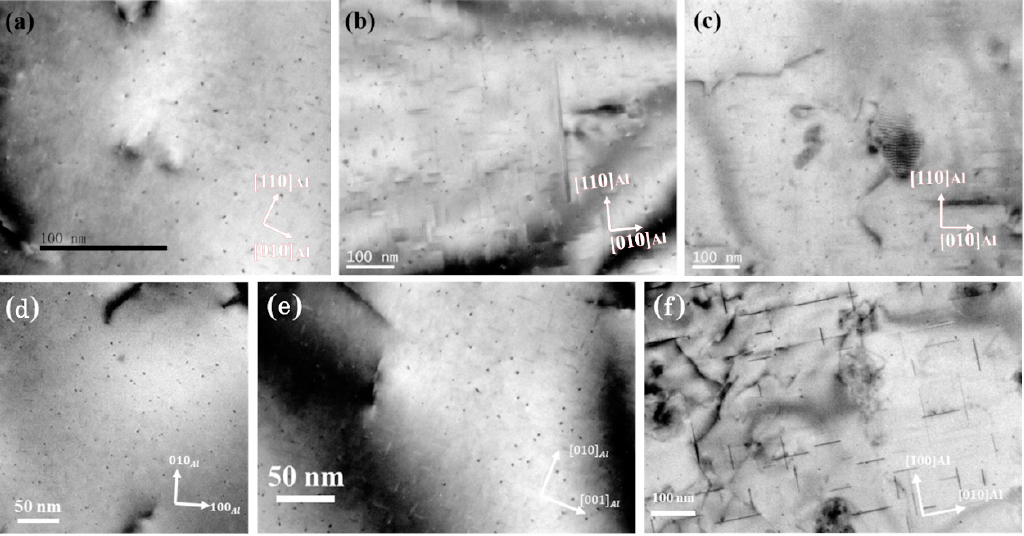
Figure 10. Microstructures of Al-7%Si-0.3%Mg-0.3%Cr alloy with 175 °C ageing by ( a ) 1 h, ( b ) 6 h, ( c ) 12 h and Al-7%Si-0.3%Mg-0.3%Cr-1.5%Cu alloy with 175 °C ageing by ( d ) 1 h, ( e ) 12 h, ( f ) 16 h.